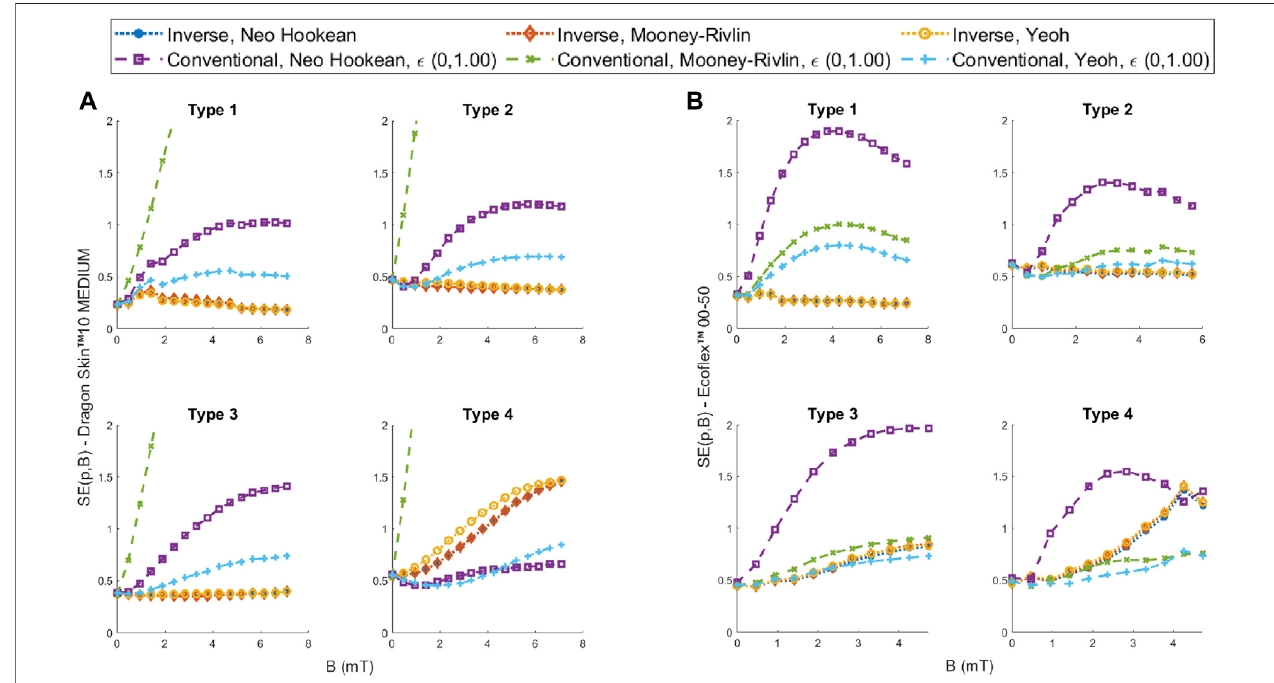
FIGURE 9 | SE comparison between the models fi tted using the EIMI and the conventional method using 100% of the engineering strain for increasing magnetic fi elds for (A) Dragon Skin ™ 10 Medium and (B) Eco fl ex ™ 00-50.